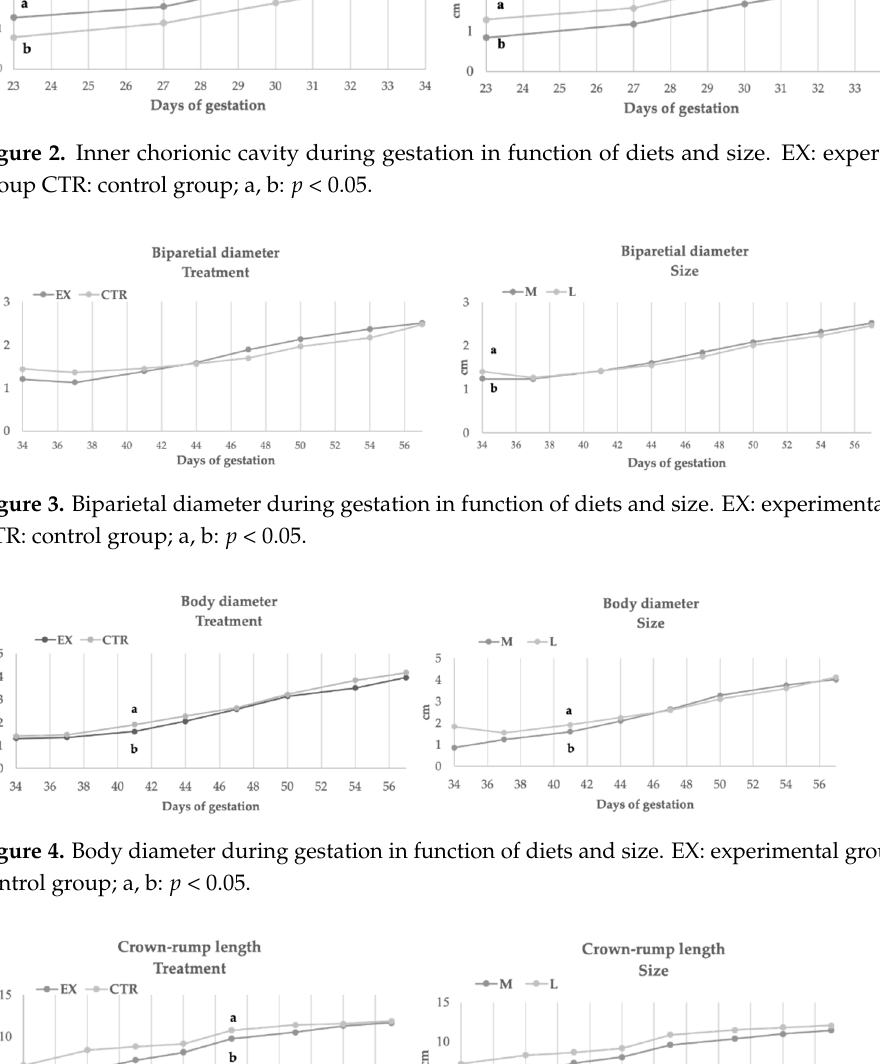
Figure 6. Percentage of fetal resorption recorded by ultrasound checks between two groups. EX: experimental; CTR: control; a, b: p < 0.05 (Wilcoxon non-parametric test). Figure 7. Number of puppies per litter recorded into the groups. EX: experimental; CTR: control; a, b: p < 0.05 (Wilcoxon non-parametric test). Clinical data collected on respiratory rate, heart rate and rectal temperature was nor- mal in all subjects for the entire study period. No differences between groups were found for bitches’ body weight (Figure 8) after parturition (32.56 vs. 39.73 kg for CTR and EX